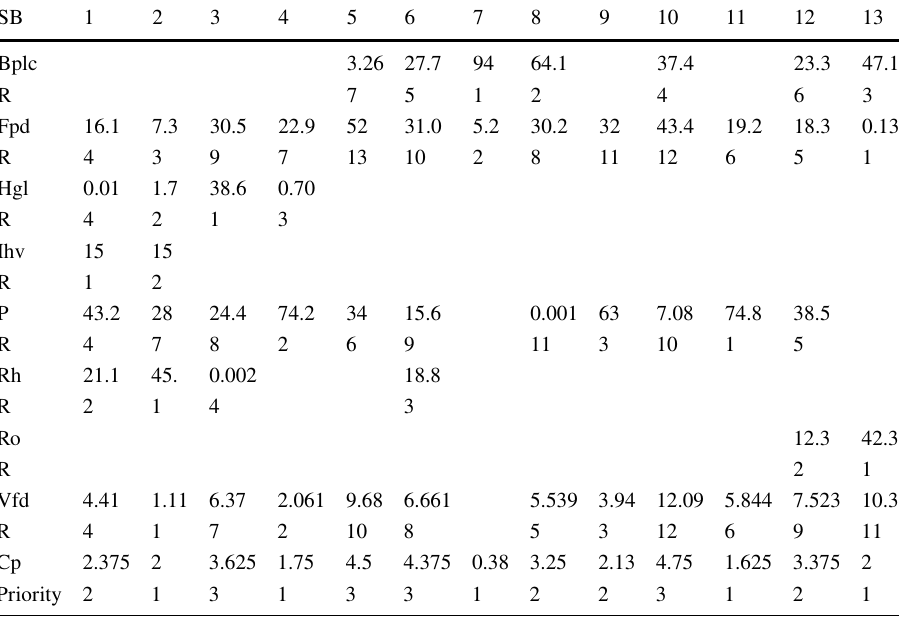
Table 7 Geomorphic analysis- based assigned ranking and compound value in Kansai– Kumari inter-fluvial site